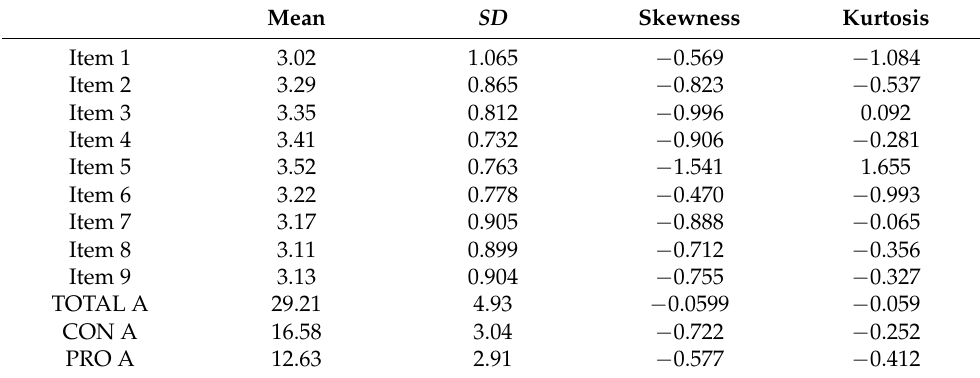
Table 2. Descriptive data of attitude items ( n = 200).